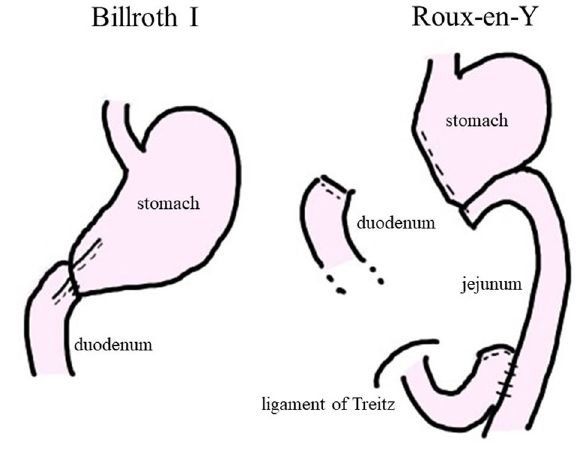
Figure 1. Figure depicting the Billroth I (BI) and Roux-en-Y (RY) reconstructions